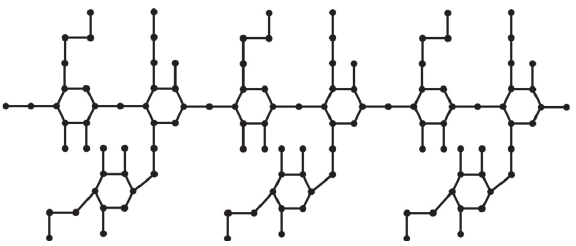
Figure 5: The molecular graph of CMHPG for n � 3.